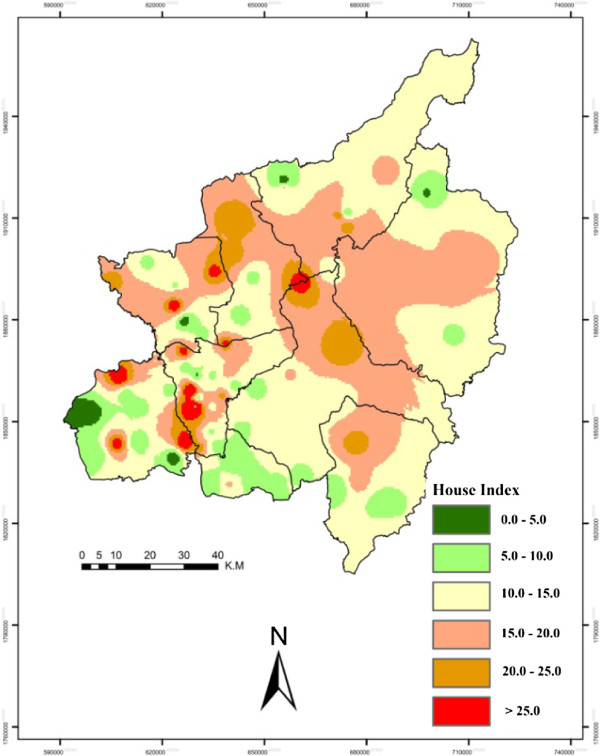
Province level house index (H.I.). This map is a visual presentation of H.I., i.e. the percentage of houses infested with larvae, using interpolation techniques on the basis of sampled villages. The legend colors show the levels of H.I. from low (green) to high (red). As per the National Institute of Health (NIH) Thailand, a H.I. of less than 1% is considered to be low risk and greater than 10% is considered to be higher risk.